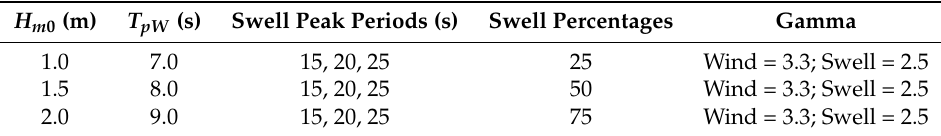
Table 1. Bimodal wave conditions tested in the present